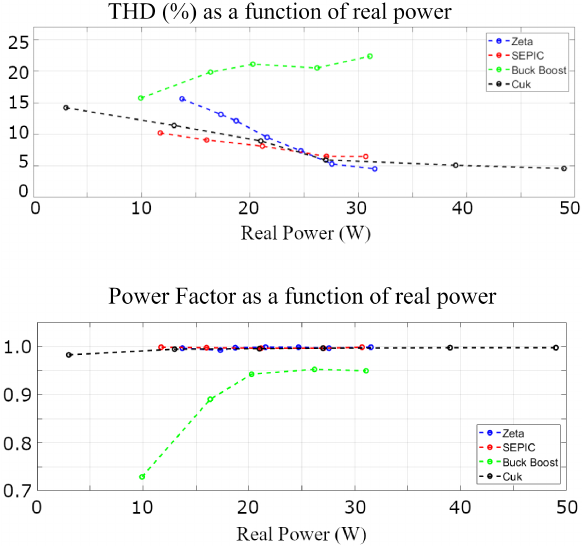
Figure 19. Comparisons of power factor and total harmonic distortion between the proposed design and other supply